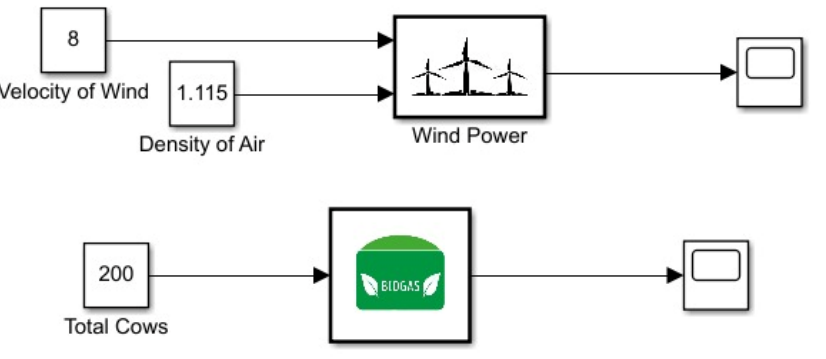
Figure 7. Power generation Simulink model.